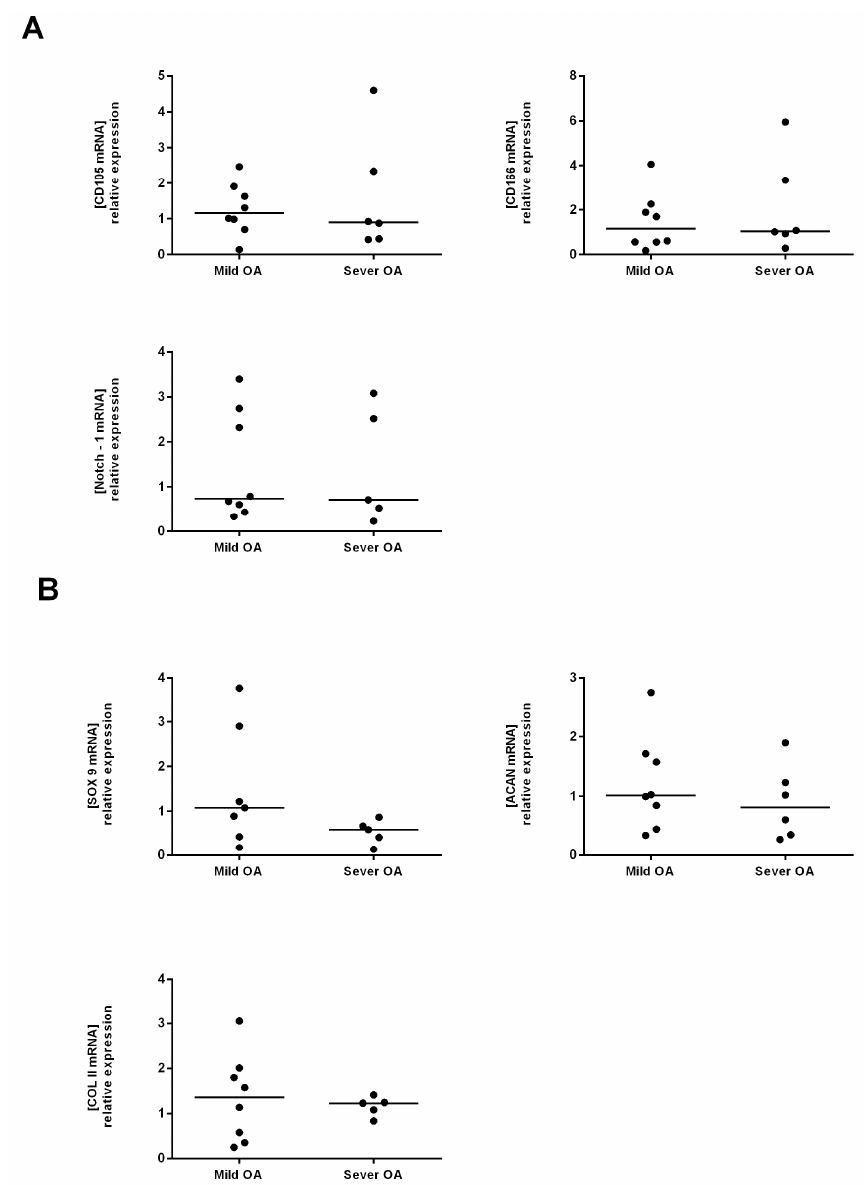
Figure 2. Comparative analysis of MSC and Chondrocyte markers in the tissue (D0) isolated from mild and severe OA regions. ( A ) The mRNA expression levels of CD105, CD166 and Notch 1 (MSC markers) in mild versus severe OA at D0; ( B ) The mRNA expression levels of Sox9, Acan and Col II (chondrocyte markers) in mild versus severe OA at D0. Mild OA is used as the control expression to normalized results.